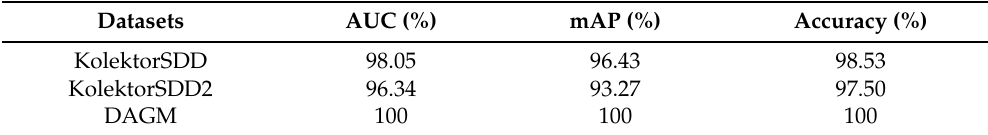
Table 3. The results of PSIC-Net in defect image